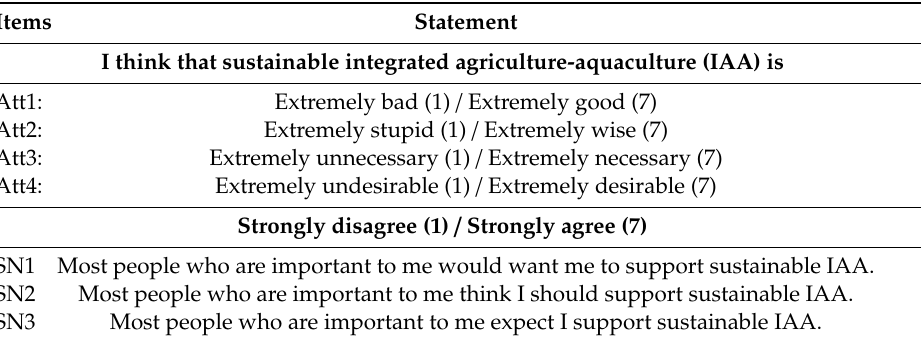
Table A1. TRA measurement